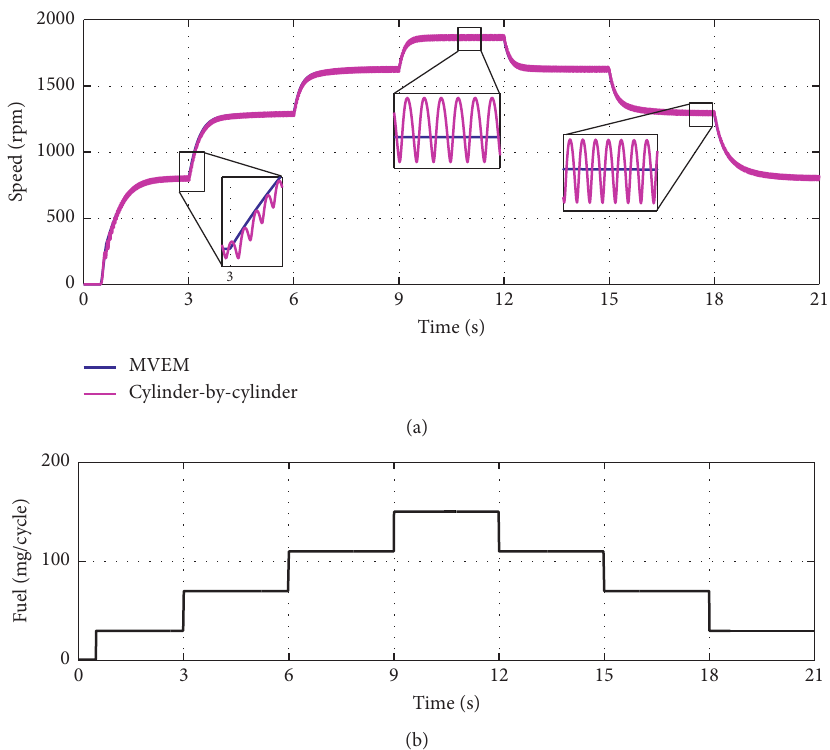
P P for one cycle of a cylinder. e , c , and